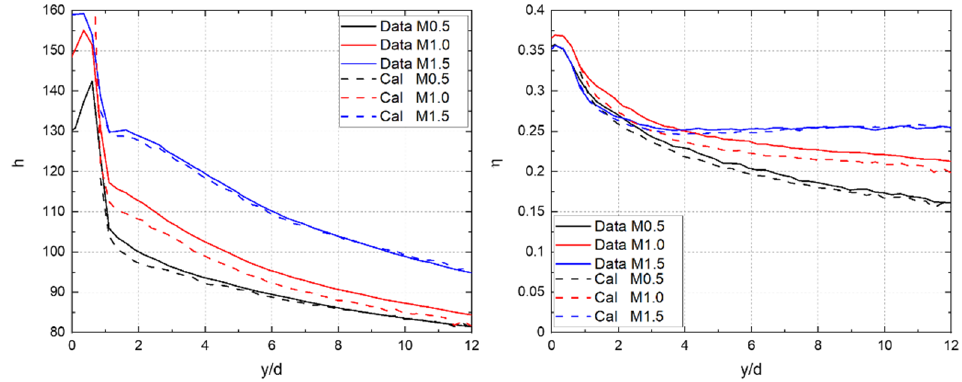
Figure 8. Comparison of span-wise averaged heat transfer coefficient and film cooling effectiveness between the data and calculation at different M for cases 1, 2, and 3.